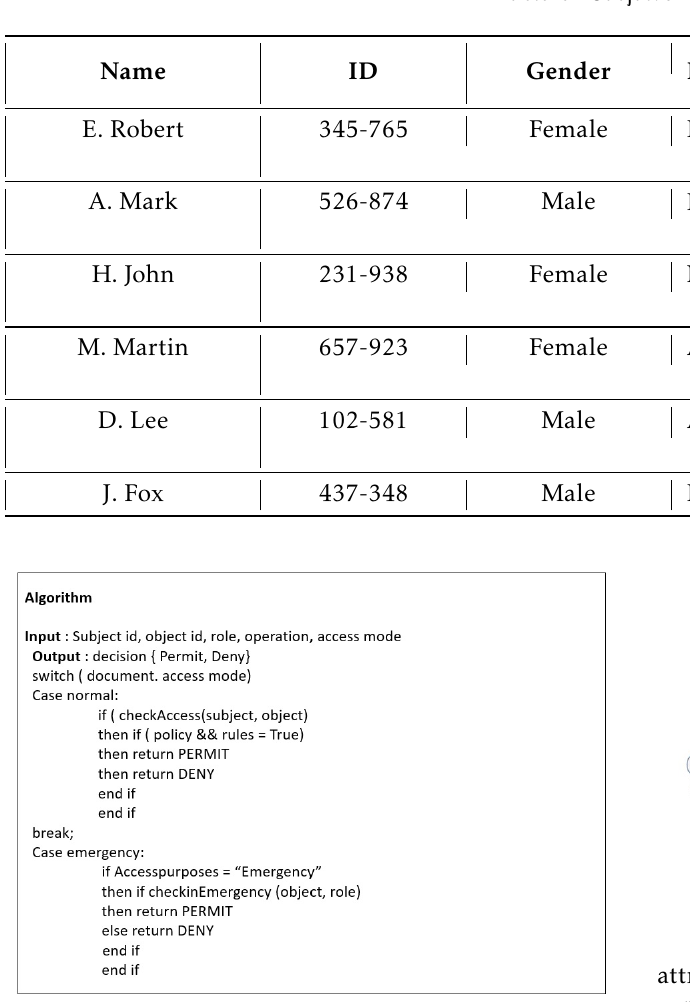
Table 3. Subject’s Attributes